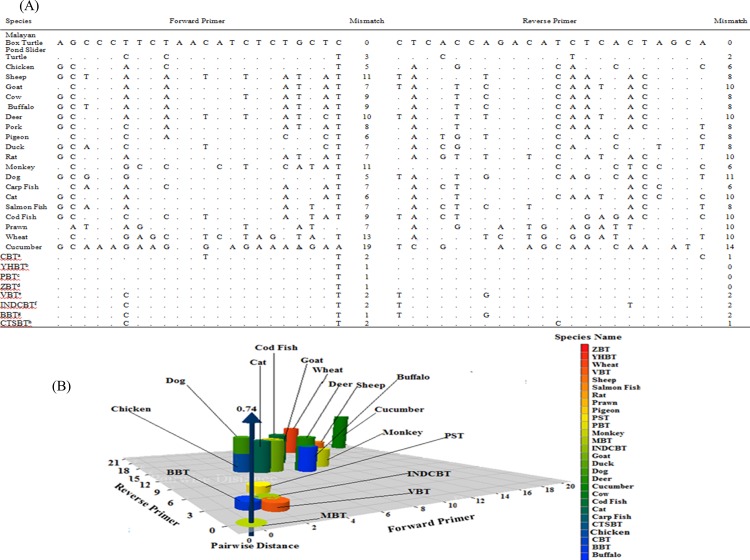
(A) The mismatch comparison of the Malayan box turtle-specific forward and reverse primers tested against 20 non-target and 8 Cuora species. (B) 3D plot showing the primer mismatch and pairwise distance. In (A), aCuora flavomarginata-Chinese box turtle (CBT), bCuora aurocapitata-yellow-headed box turtle (YHBT), cCuora pani-Pan’s box turtle (PBT), dCuora zhoui-Zhou's box turtle (ZBT), eCuora picturata-Vietnamese box turtle (VBT), fCuora galbinifrons-Indochinese box turtle (INDCBT), gCuora bourreti-Bourret’s box turtle (BBT) and hCuora trifasciata-Chinese three-striped box turtle(CTSBT) are shown. In (B), 3D plot showing the primer mismatch and pairwise distance between the Malayan box turtle and 20 studied species including 8 species of the Cuora genus.